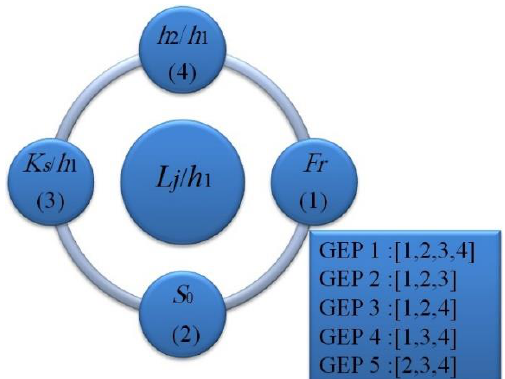
Figure 4. Combinations of the input parameters for simulating objective function of hydraulic jump length for different GEP